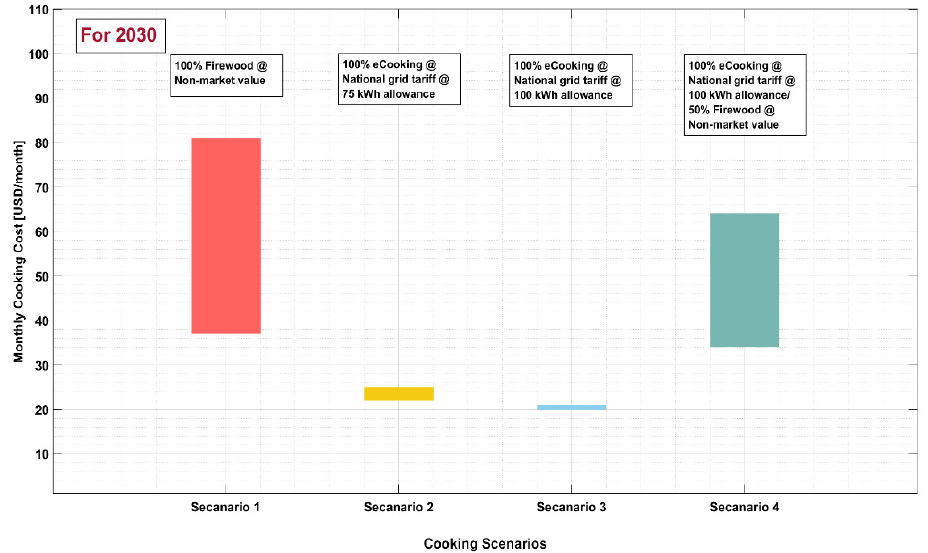
Figure 5. Monthly cooking cost of the contextualized cooking scenarios to close the affordability gap for 2030.